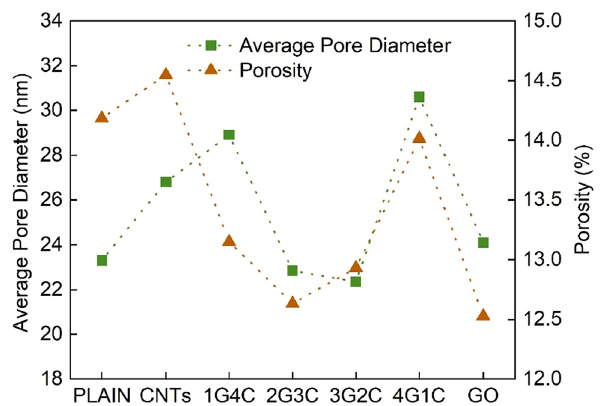
Figure 27: Porosity and average pore diameter of pastes with var - ious GO: CNTs ratios [ 147 ]